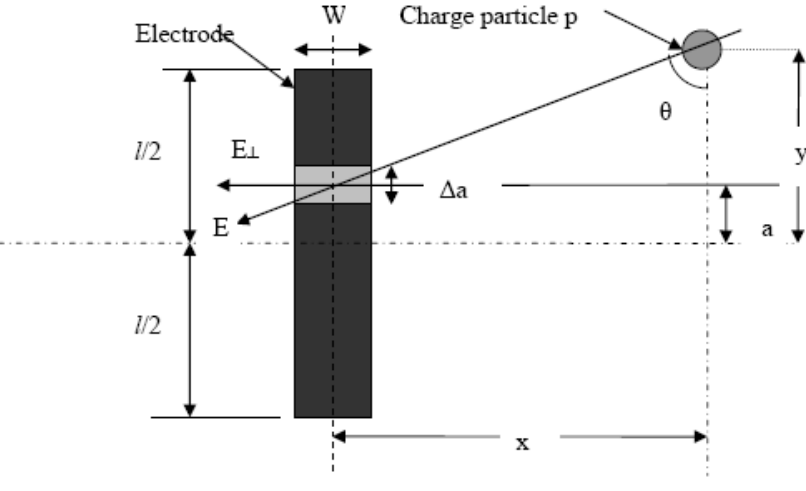
Figure 1. Mathematical model of electrostatic signal on moving